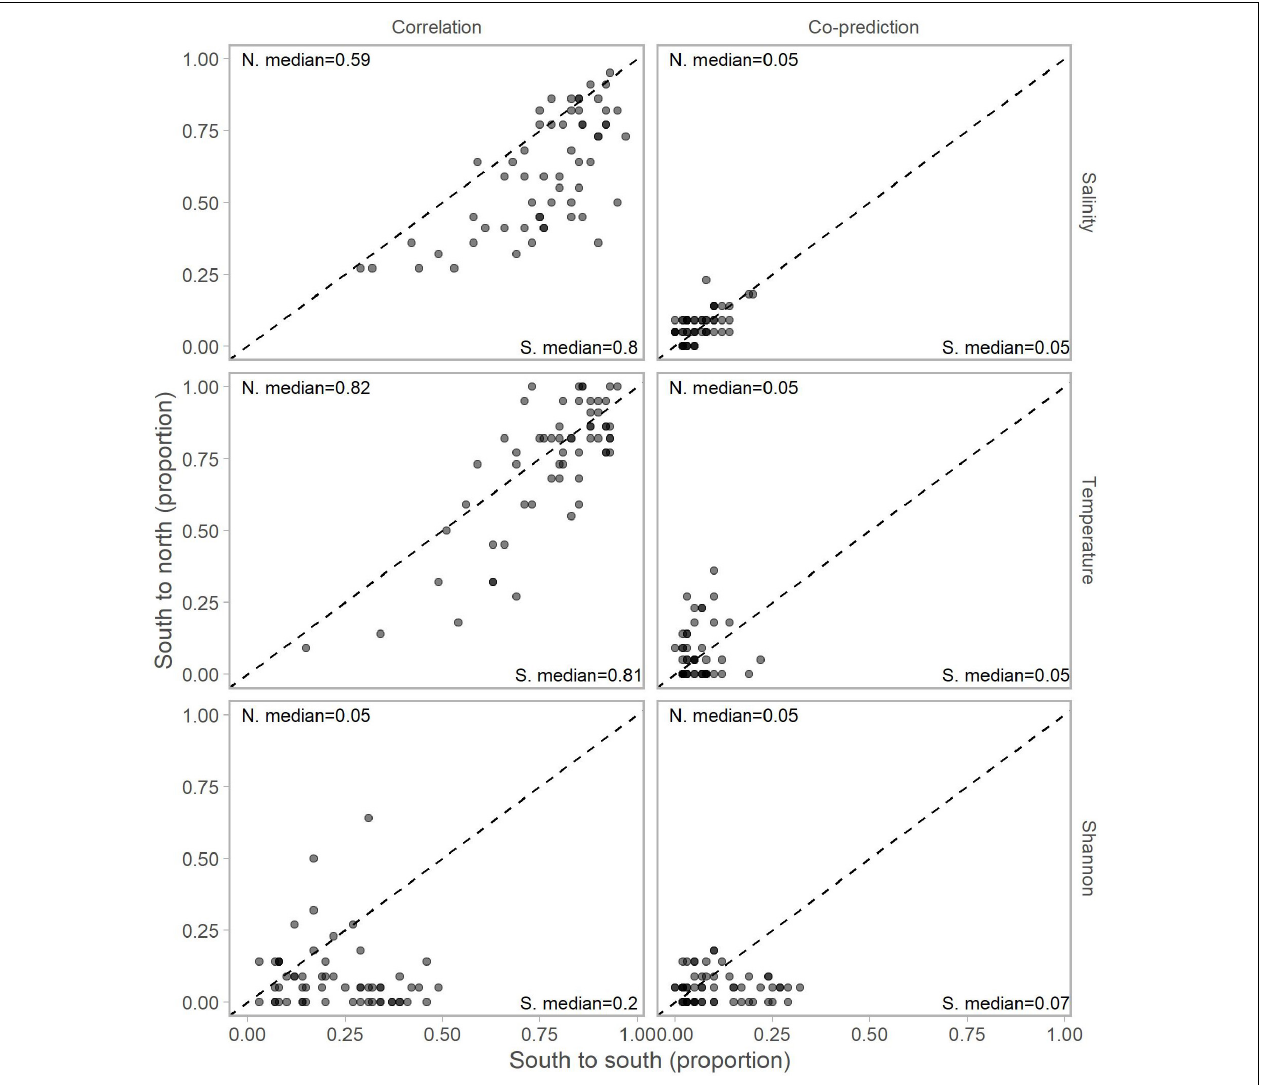
FIGURE 4 | Proportions of south stations correlated (left column) and co-predicted (right column) with stations south (x-axis) and north (y-axis) of Point Conception.There were 59 stations south and 22 stations of Point Conception. Panels show results for the three data types: salinity (top row), temperature (middle row), and Shannon indices (bottom row). The median proportions for predicted stations south (bottom right of each panel) and north (top left of each panel) of Point Conception. The dashed line shows the one-to-one